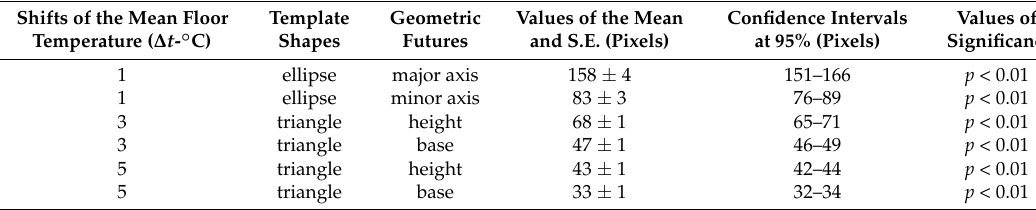
Table 3. Shapes and geometric features of the templates used to perform the image pattern recognition procedures in the following field tests. For each geometric feature, the corresponding mean floor temperature shift investigated is reported (i.e., 1, 3, and 5 ◦ C). Furthermore, the results obtained performing a Student’s t -Test procedure on data collected in terms of means, standard error (S.E.), confidence intervals and significance of the means, are also shown in the